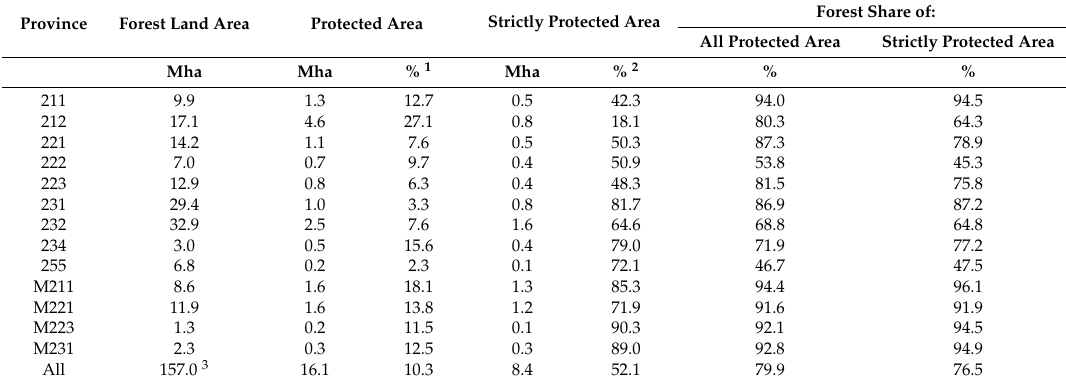
Table 2. IUCN protected forest land